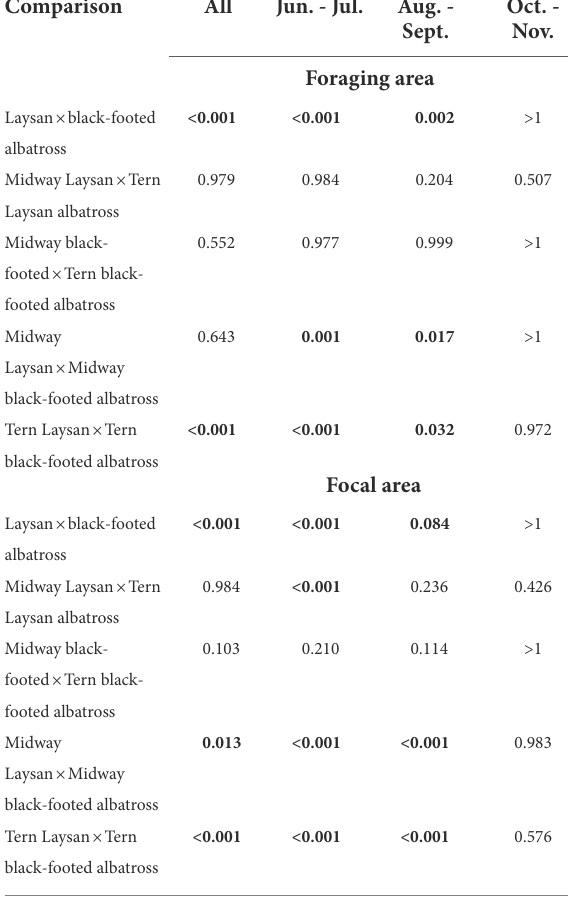
TABLE 5 p values for comparisons conducted using the CRW randomization method by bi-monthly periods and in aggregate (aggregate category includes all post-breeding points, including those outside the June–November temporal